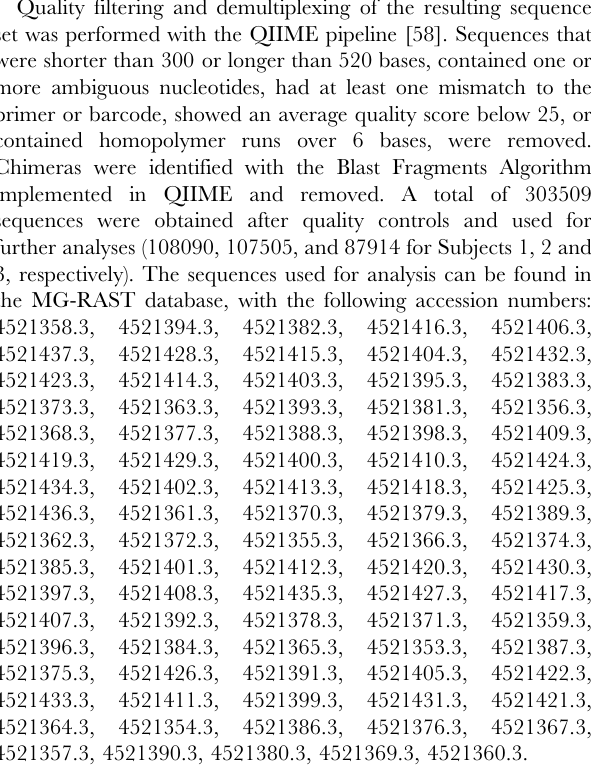
Figure S2 Presence-absence patterns of dominant bac- terial taxa in the fecal samples of human subjects over the entire study period. Sequences were taxonomically classified (Classifier, RDP) and the presence (red) and absence (white) patterns of the most dominant bacterial taxa are presented for each sample at the phylum, order, family and genus levels. Samples are grouped by subject and presented in chronological order. Figure S3 Resilience of core members to dietary perturbations. Abundance of Bifidobacterium adolescentis in fecal samples of (A) subject 1 (showing an increase in abundance due to the intake of both resistant starches and GOS) and (B) subject 2 (showing increase only with resistant starches) and (C)